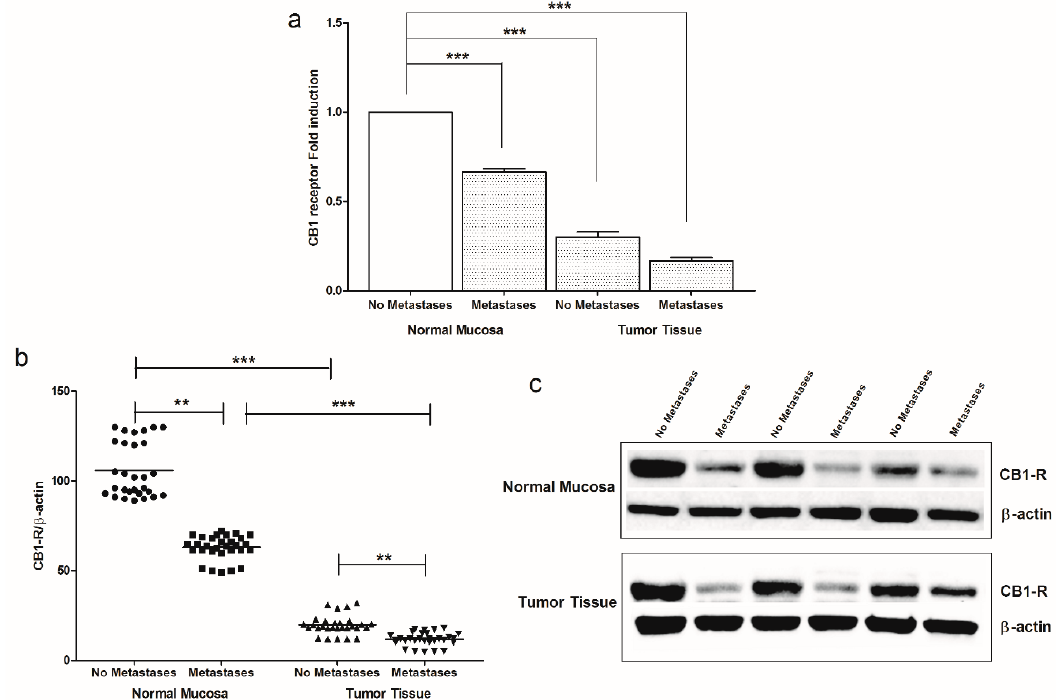
Figure 1. ( a ) CB1 receptor gene expression levels in intestinal tissue of no metastases ( n = 29 patients) and with metastases patients ( n = 30 patients) detected in both normal mucosa and tumor tissue. Data, expressed as mean value ± SD, are presented as fold induction compared to normal mucosa of patients without metastases. ( b ) Dot plots graph of CB1 receptor protein values detected in our patients groups. ** p < 0.02, *** p < 0.001 indicate statistically significant differences (one-way analysis of variance with Dunnett’s and Tukey’s multiple comparison test, where appropriate). ( c ) Representative Western blot bands of CB1-R and β -actin proteins. All Western blot figures include a dot plots graph showing the densitometry values of each sample (band) normalized to β -actin value. The whole blot has been provided as Supplemental Materials (Figure S1).